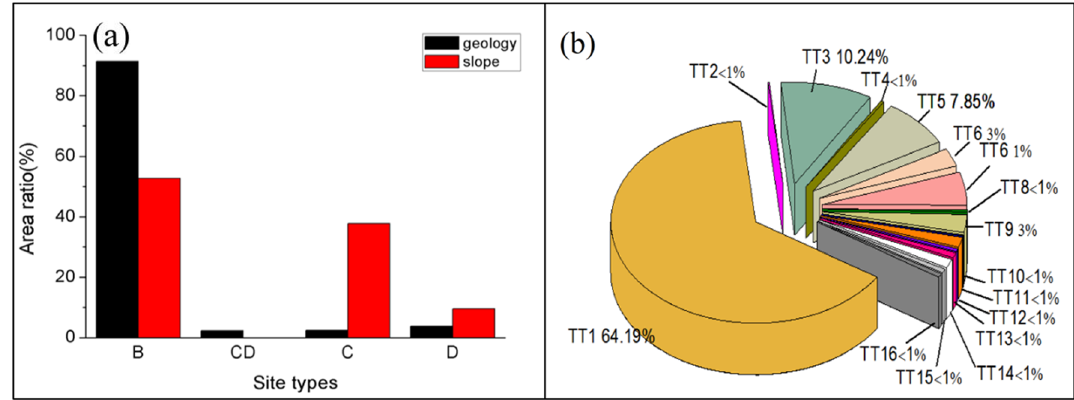
Fig. 3 Site classification area ratio of: a the geology-based approach and topographic slope-based approach; and b the terrain-based